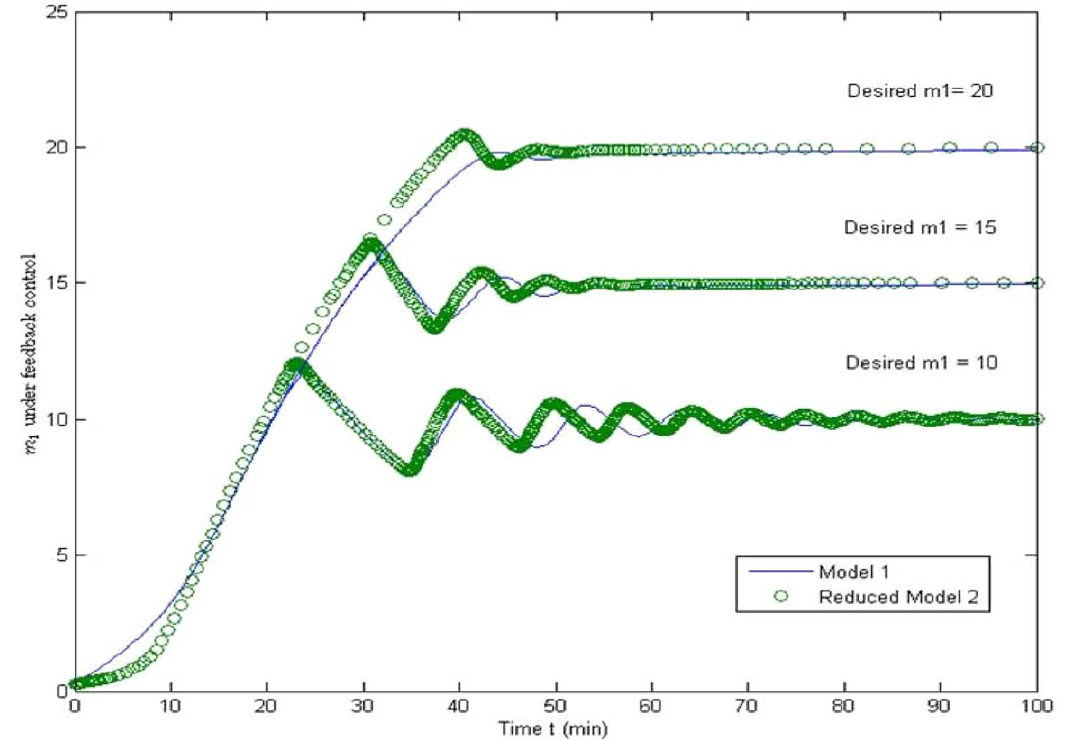
Figure 8. Comparison of referenced tracking between the original model and the reduced model using feedback control. Under the feedback control, the tracking performance of the original model and the reduced model is similar. Thus, the control design based on the reduced model can be applied to the original model directly.